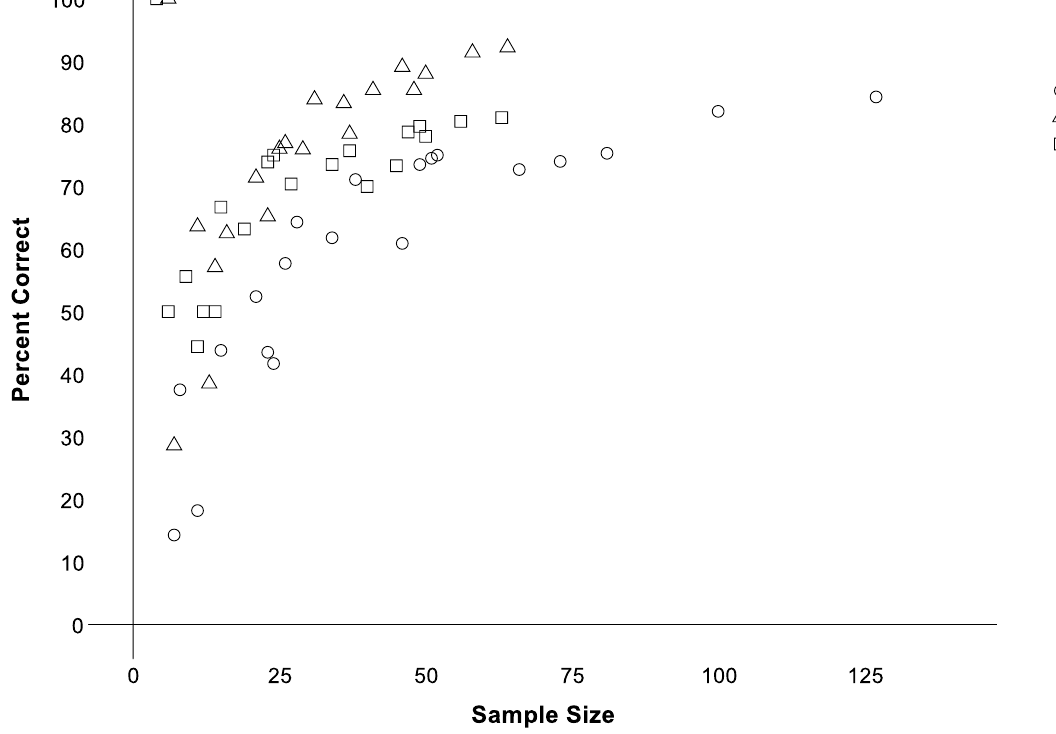
Figure 1. A scatter plot of sample size by allocation accuracy for the Coimbra collection subsamples for 60 trials modeling various mass grave scenarios.